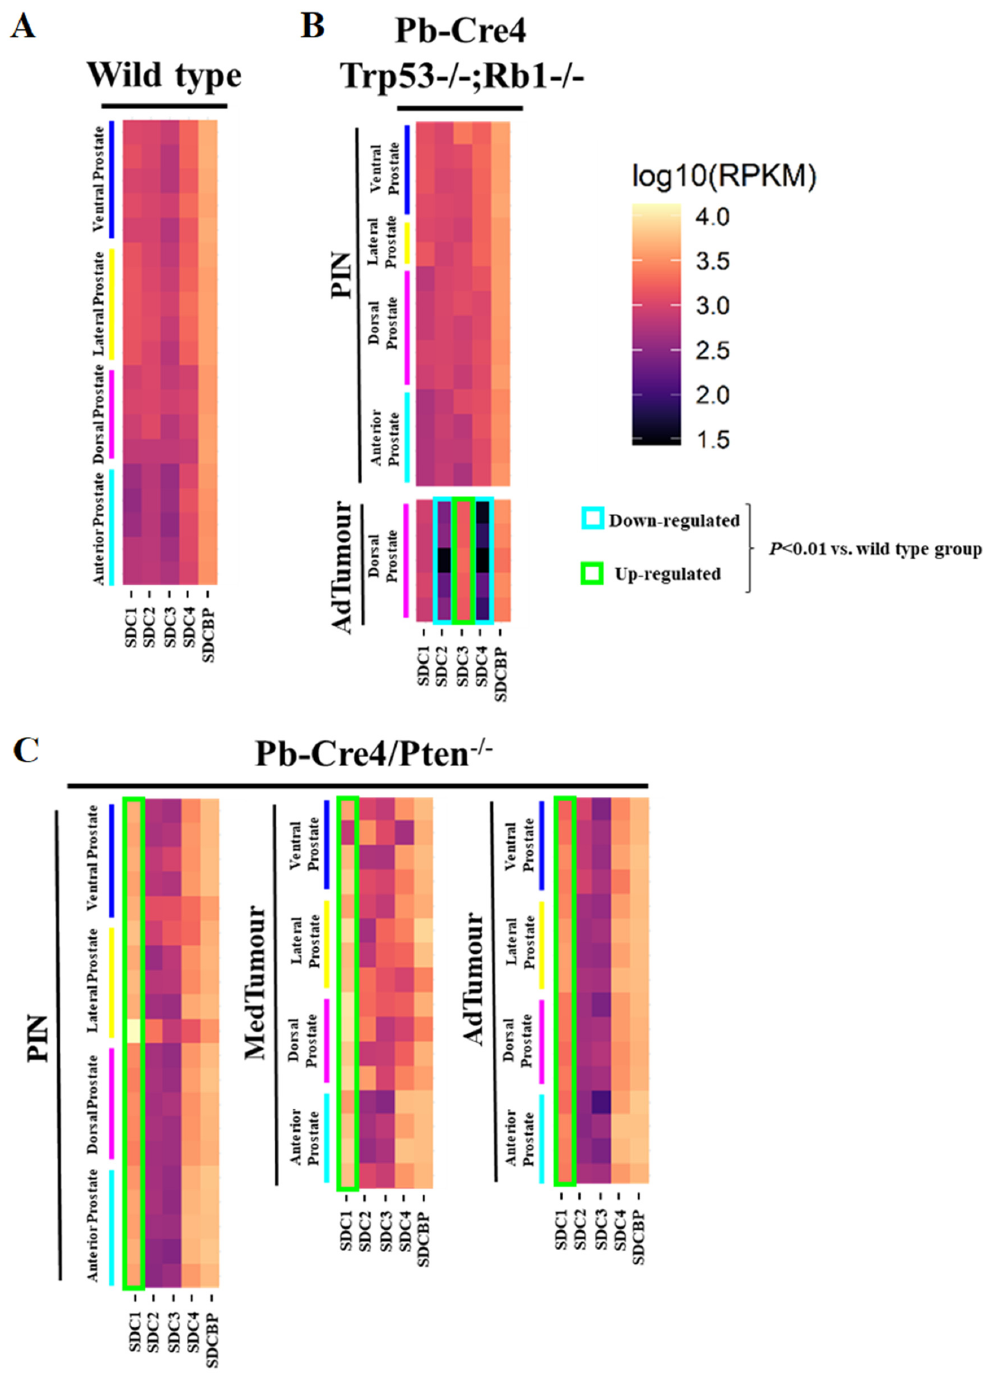
Figure 1. Heatmaps illustrate RNA-Seq differential expression data of the Sdc1 , Sdc2 , Sdc3 , Sdc4, and Sdcbp genes across different prostatic lobes, mouse models, and tumor stages. ( A ) Non-neoplastic tissue ( Pb-Cre4 -negative—wild type) controls; ( B ) Pb-Cre4/Trp53 f/f ;Rb1 f/f double conditional knockout mouse (p53/Rb mouse); ( C ) Pb-Cre4/Pten f/f mouse (Pten mouse). The heatmaps represent Log 10 of normalized RPKM values. PIN Stage—prostatic intraepithelial neoplasia; MedTumor—medium-stage tumor, micro-invasive adenocarcinomas; AdTumor—tumor in a more advanced stage, invasive adenocarcinomas. Note that significant upregulation of Sdc1 in the Pten mouse (*** p < 0.0001 vs. control group), a significant upregulation of Sdc3, and downregulation of both Sdc2 and Sdc4 in advanced tumors from the p53/Rb mouse were also observed ( p < 0.0001 vs. wildtype